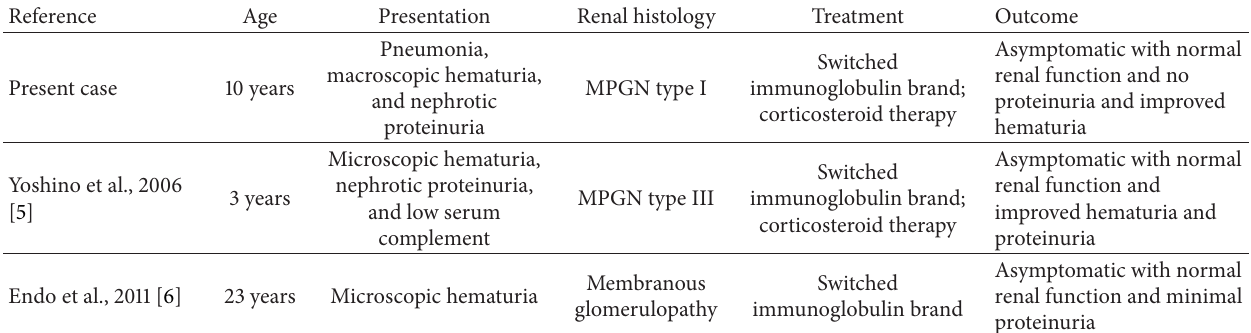
Table 1: Patients with XLA and renal disease due to immune complex